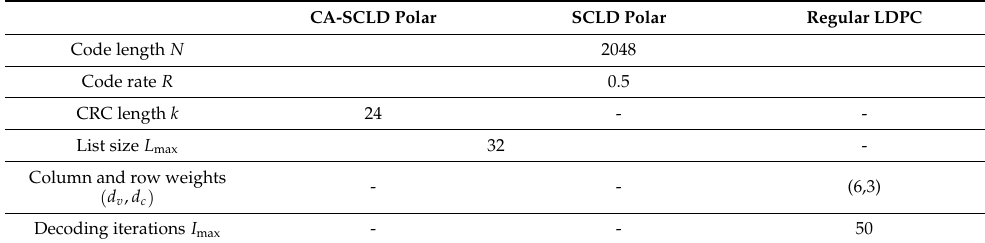
Table 1. Parameters of error-correcting codes used in the experiment.